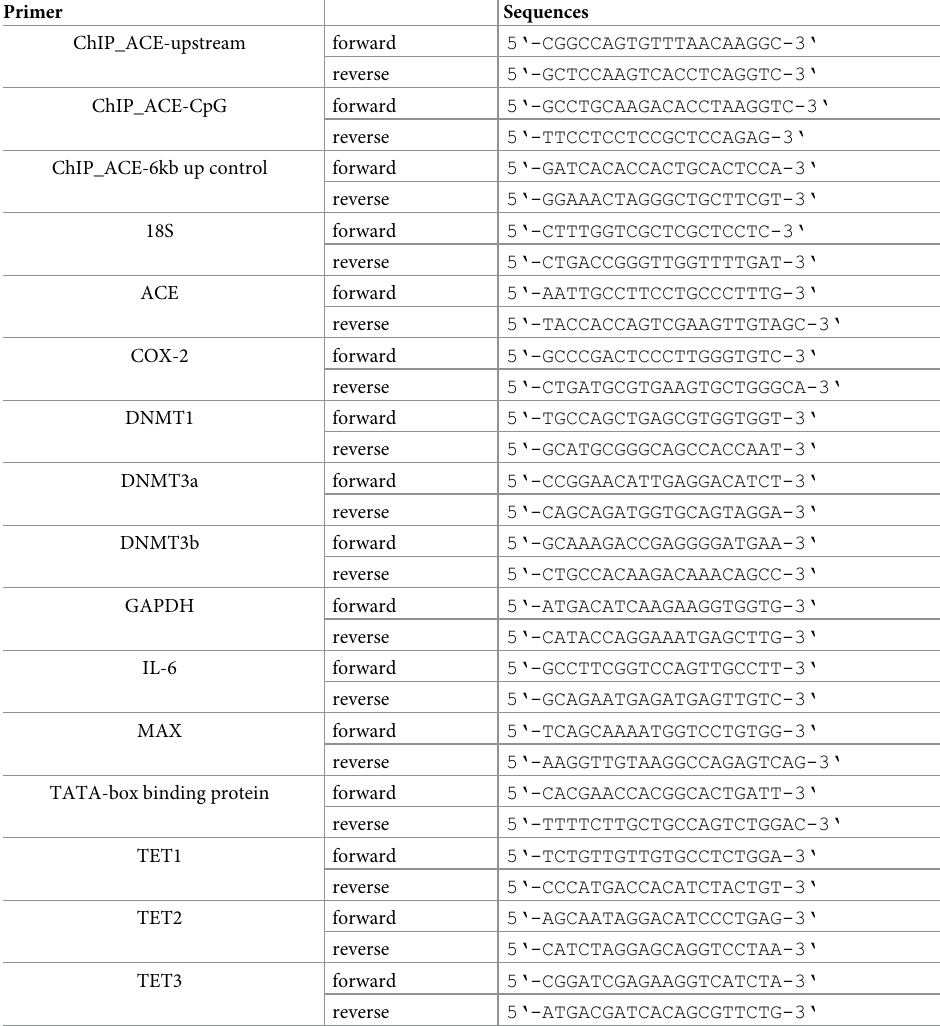
Table 1. Primer sequences for